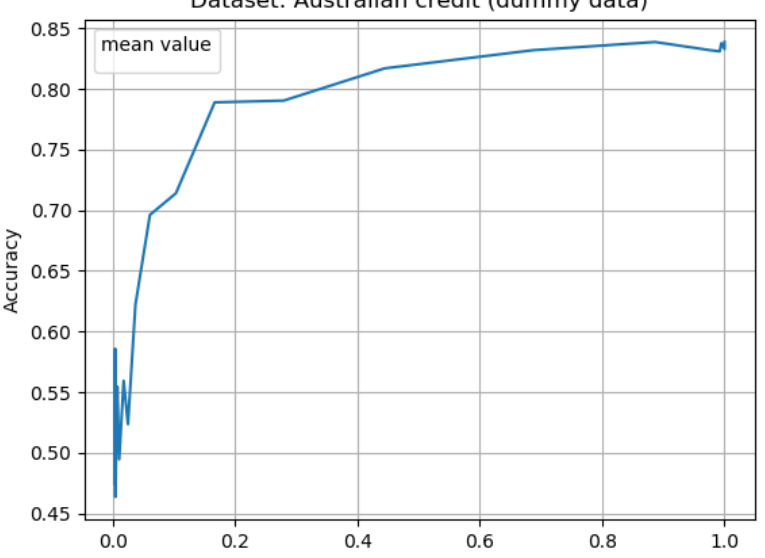
Figure 10. Dummy variables - mean result for 10 learning cycles, using 10 splits; for Australian credit data set; after conversion to Dummy variables its 35